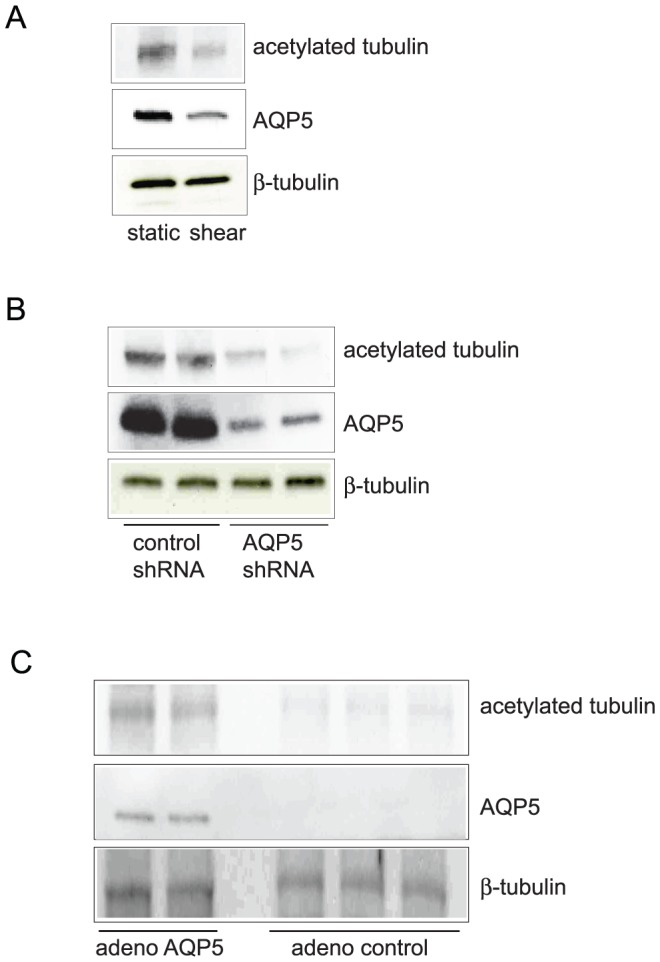
Changes in AQP5 are associated with altered acetylated tubulin (n=6, per condition, representative blots shown).A. Shear stress, which causes decreased AQP5, led to decreased acetylated tubulin with no change in total tubulin. B. In NHBE cells, AQP5 knockdown resulted in decreased acetylated tubulin, with no change in total tubulin. C. Overexpression of AQP5 resulted in increased acetylated tubulin in 16HBE cells.